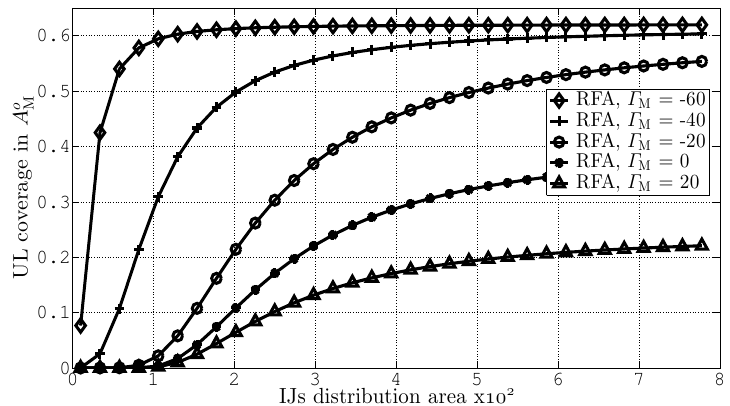
Figure 7. UL coverage against radius for IJs distribution area, with RFA.